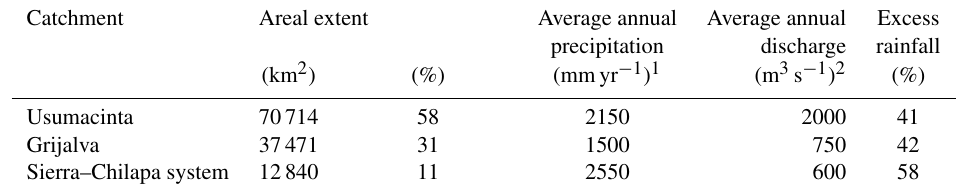
Table 1. General characteristics for the watersheds of the main rivers draining towards the Usumacinta–Grijalva